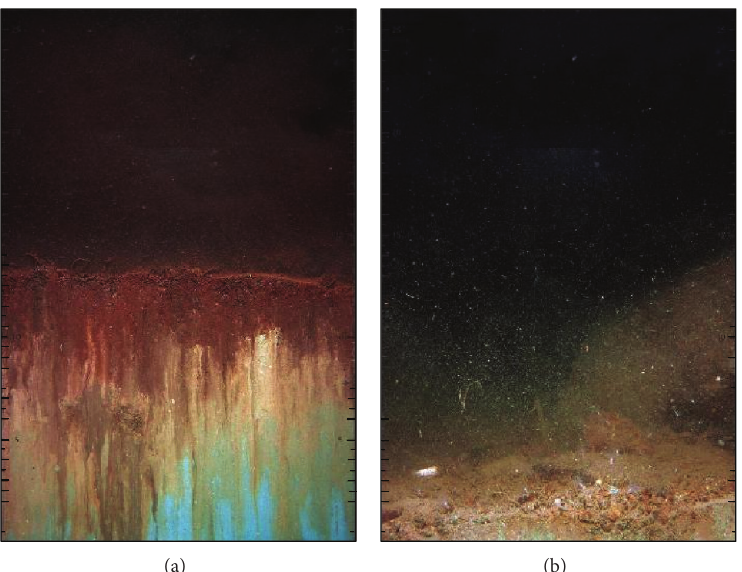
Figure 6: Sediment profiles images (SPIs) of sites 7 (a) and 25 (b) showing the difference in sediment particle composition and environment at the two extremes of DCA1.